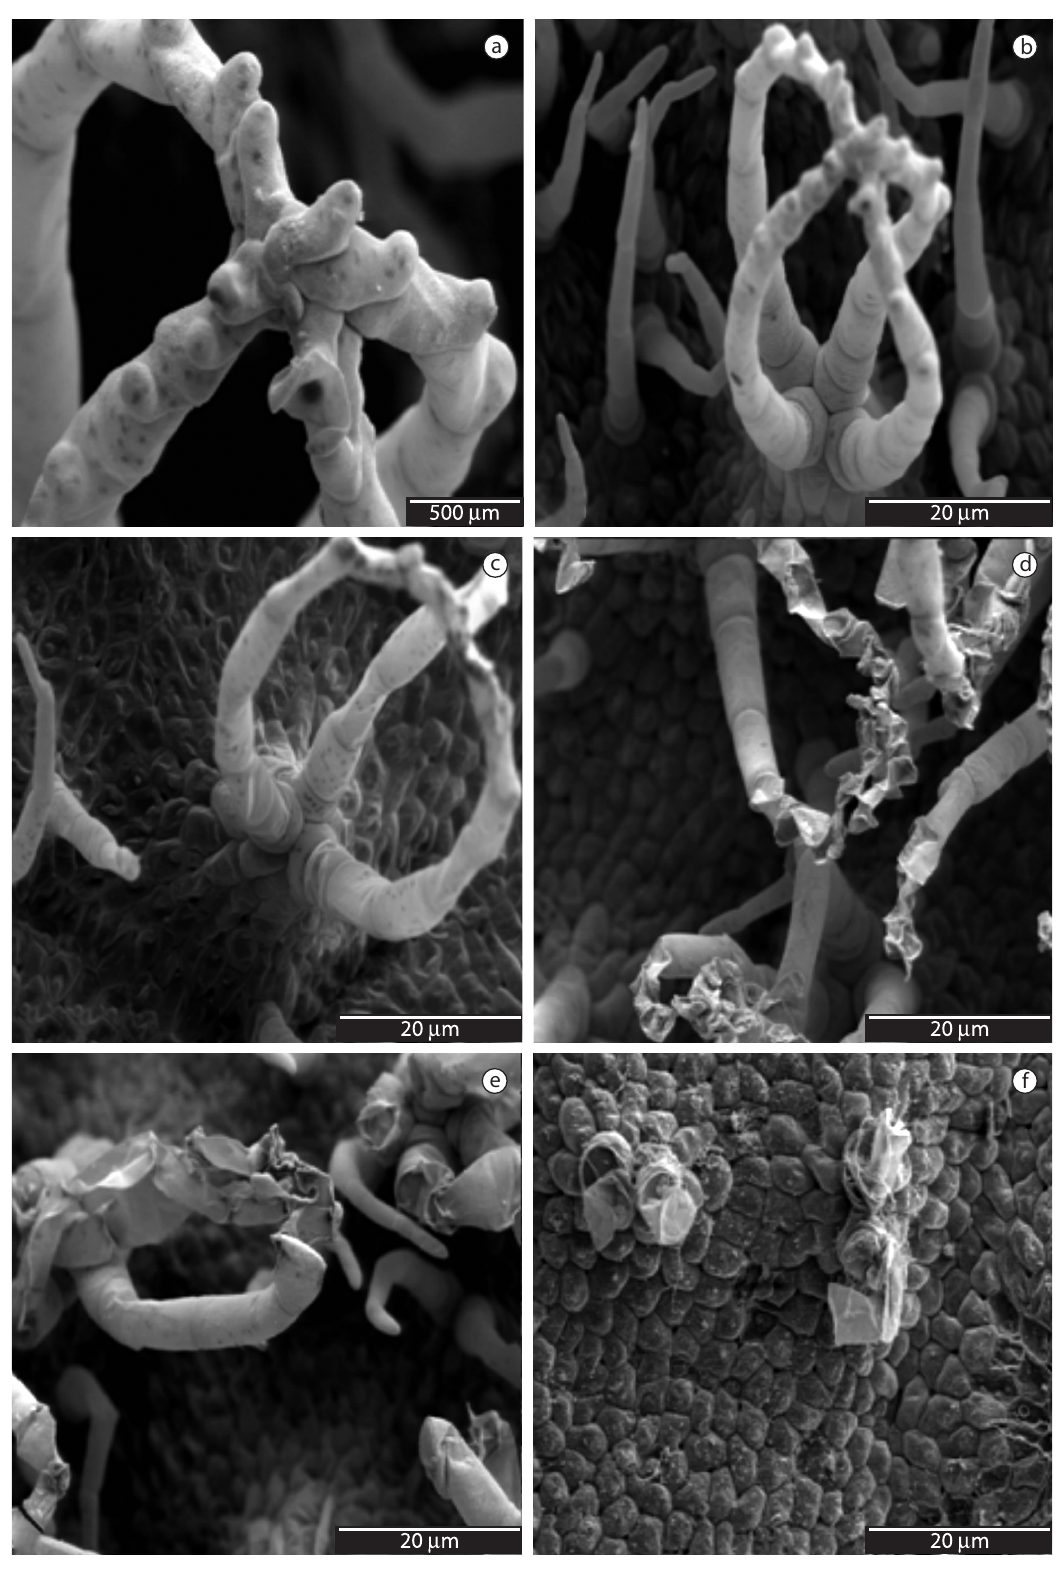
Figure 2. Scanning electron microscopy of the adaxial leaf surface of Salvinia auriculata . a) and b) Plant control, c) plant subjected to 100 mM NaCl, d) plant subjected to 200 mM NaCl, e) plant subjected to 100 mM Na f) plant subjected to 200 mM Na